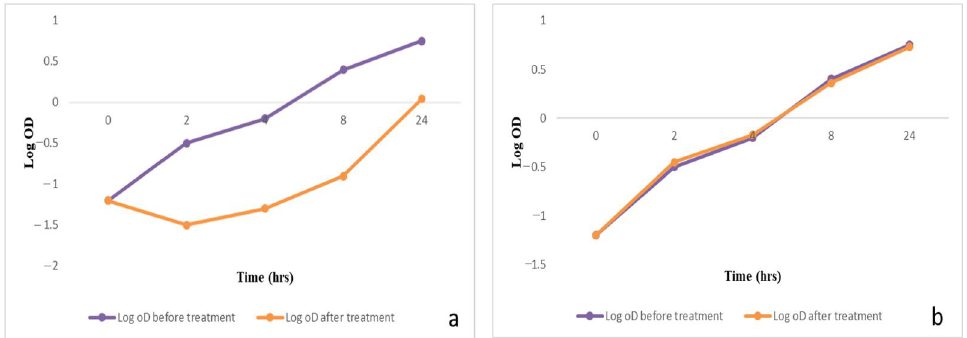
Figure 2. A graph showing P. gingivalis growth curves: ( a ) a significant decrease in bacterial growth after treatment with the frankincense extract (0.5 MIC); ( b ) non-significant change in the growth curve after treatment with 10%DMSO.